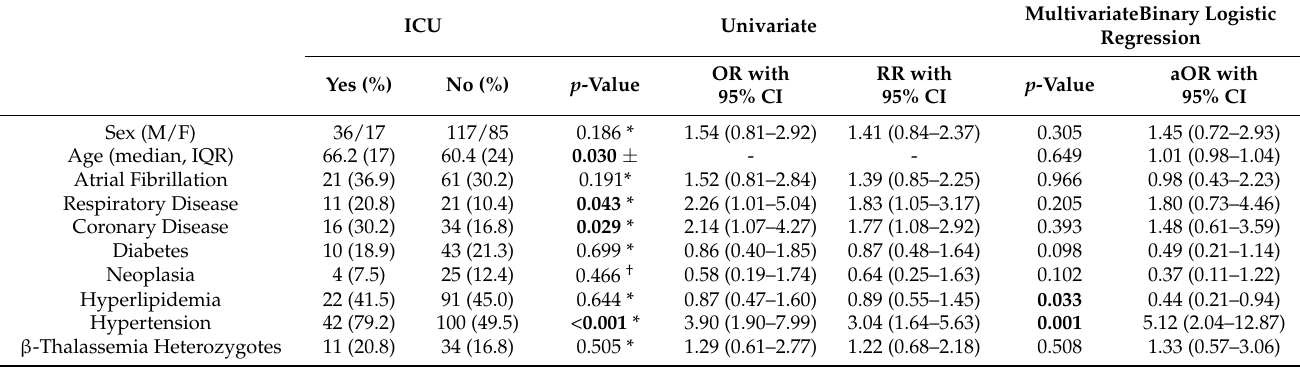
Table 3. Characteristics and ICU admission due to